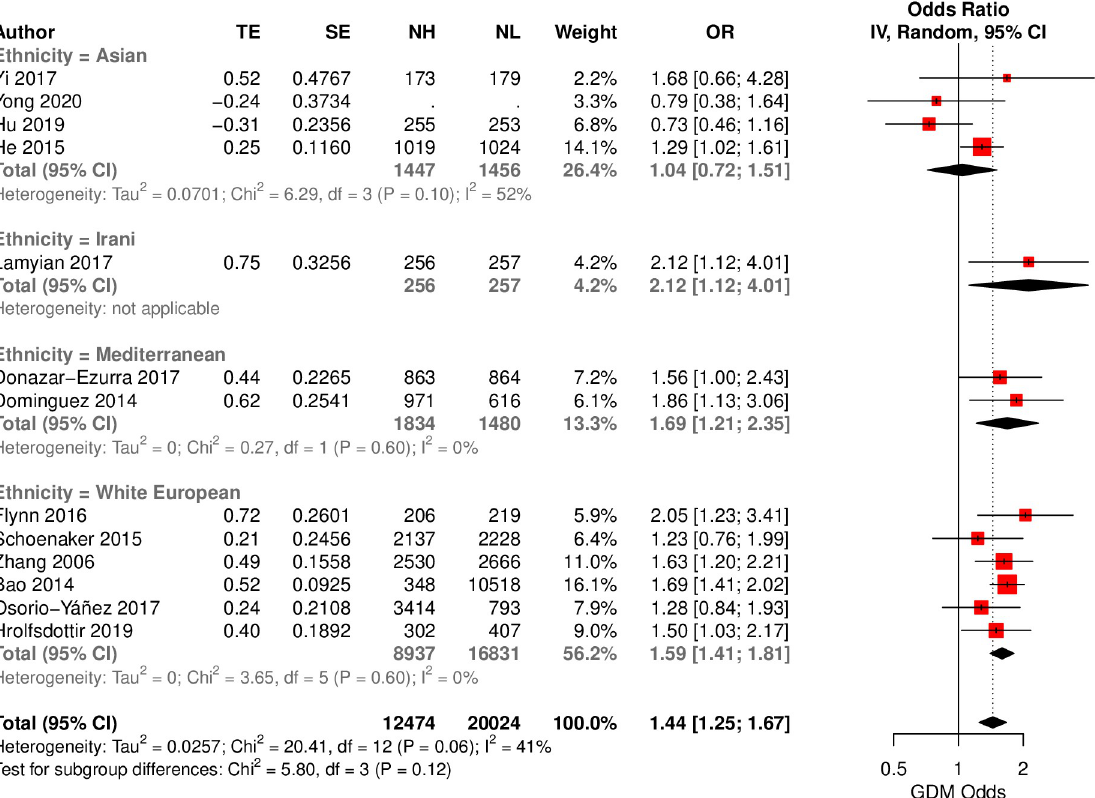
Fig 4. Forest plot of reported associations between unhealthy dietary interventions an odds of GDM in ethnically–defined observational studies. Forest plot illustrating the association between habitual unhealthy dietary intake and GDM in distinct ethnicities. TE: treatment effect, SE: standard error, IV: inverse variance method, CI: Confidence